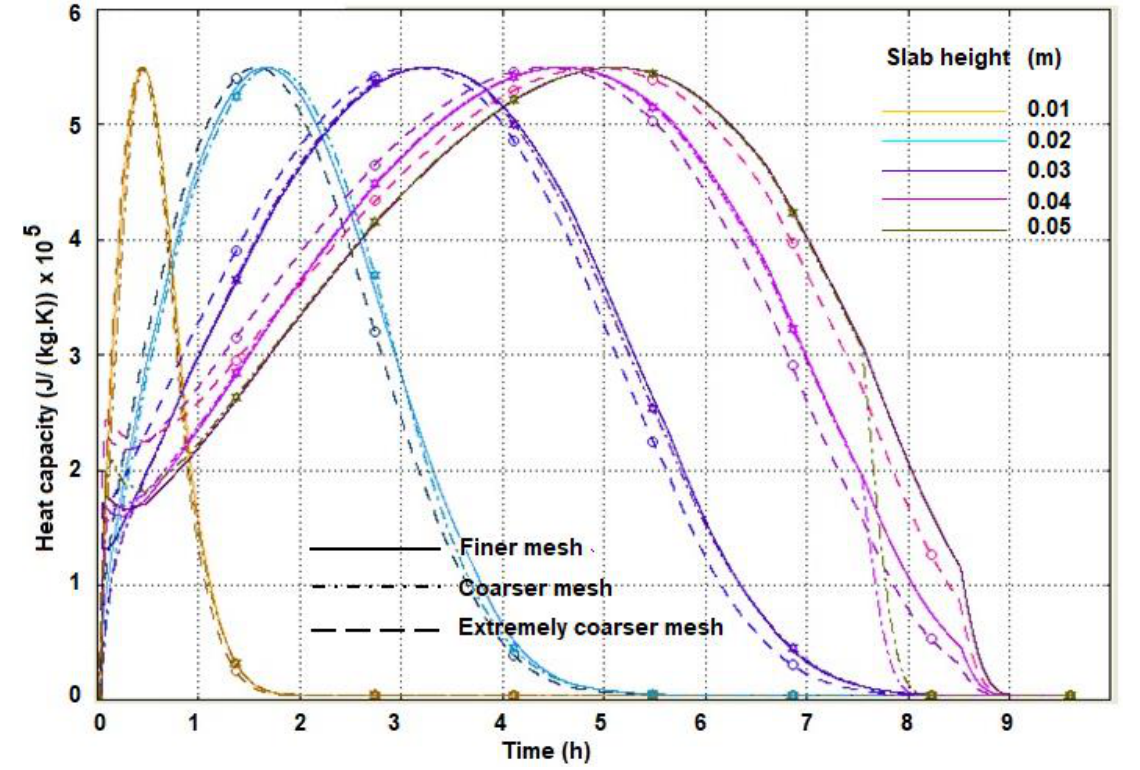
Figure 11. Effect of meshing qualities on the heat capacity.